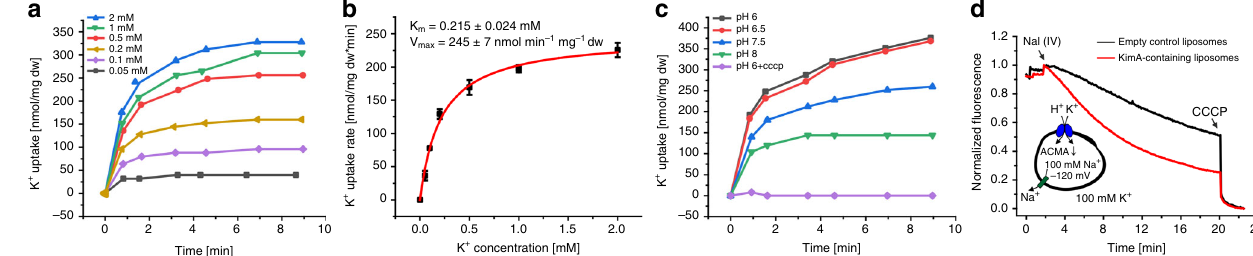
Fig. 1 Functional analysis of KimA. a Concentration-dependent potassium uptake via KimA into potassium-depleted E. coli LB2003 cells. n = 3 independent experiments; a representative experiment is shown. b , Kinetic parameters of the potassium transport via KimA determined based on ( a ). The plotted uptake rates at different potassium concentrations are the means of three independent experiments; errors shown are s.d. c pH-dependent potassium transport via KimA into potassium-depleted E. coli LB2003. n = 3 independent experiments; a representative experiment is shown. d Potassium- dependent proton transport into KimA-containing liposomes. n = 3 independent experiments; a representative experiment is shown. Source data are provided as a Source Data fi